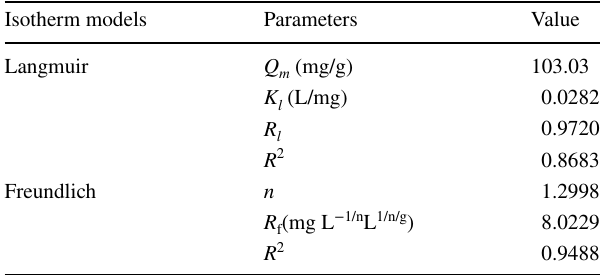
Table 1 Isotherm parameters for the adsorption of MO onto Anchote peel adsorbent at 25 °C Isotherm models